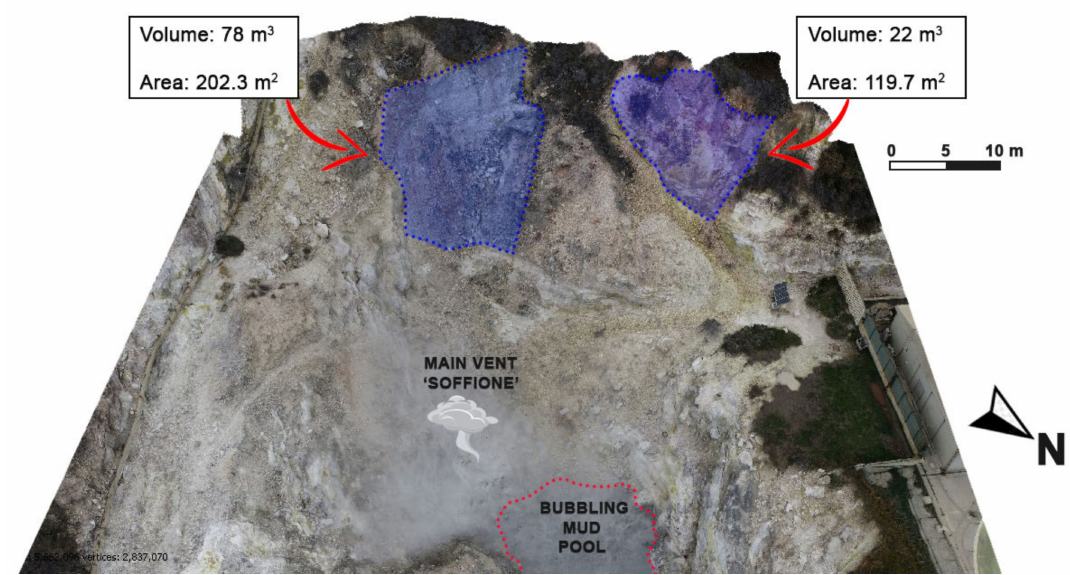
Figure 12. The 3D model of the western side of the Pisciarelli fumarole field. During a year of survey, we identified two main landslide areas which prompted the accumulation of rocks and mud after intense rainfall or seismic events. Photo obtained by the November 2020 survey.